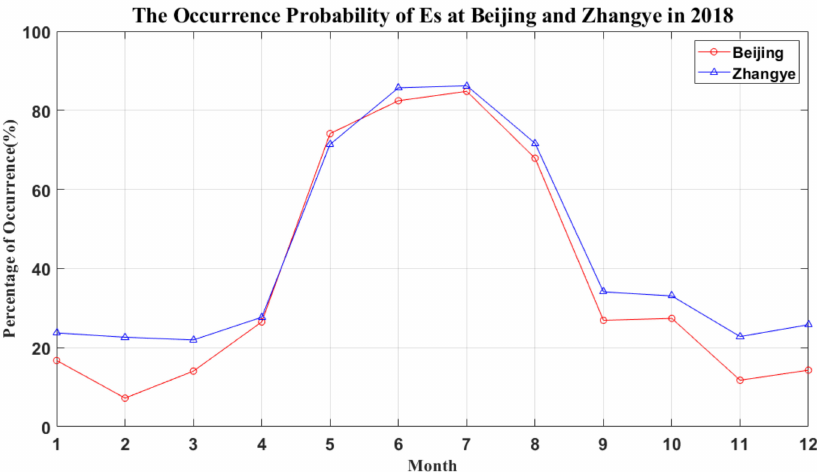
Figure 6. Seasonal changes in the occurrence probability of the Es layer at Beijing and Zhangye